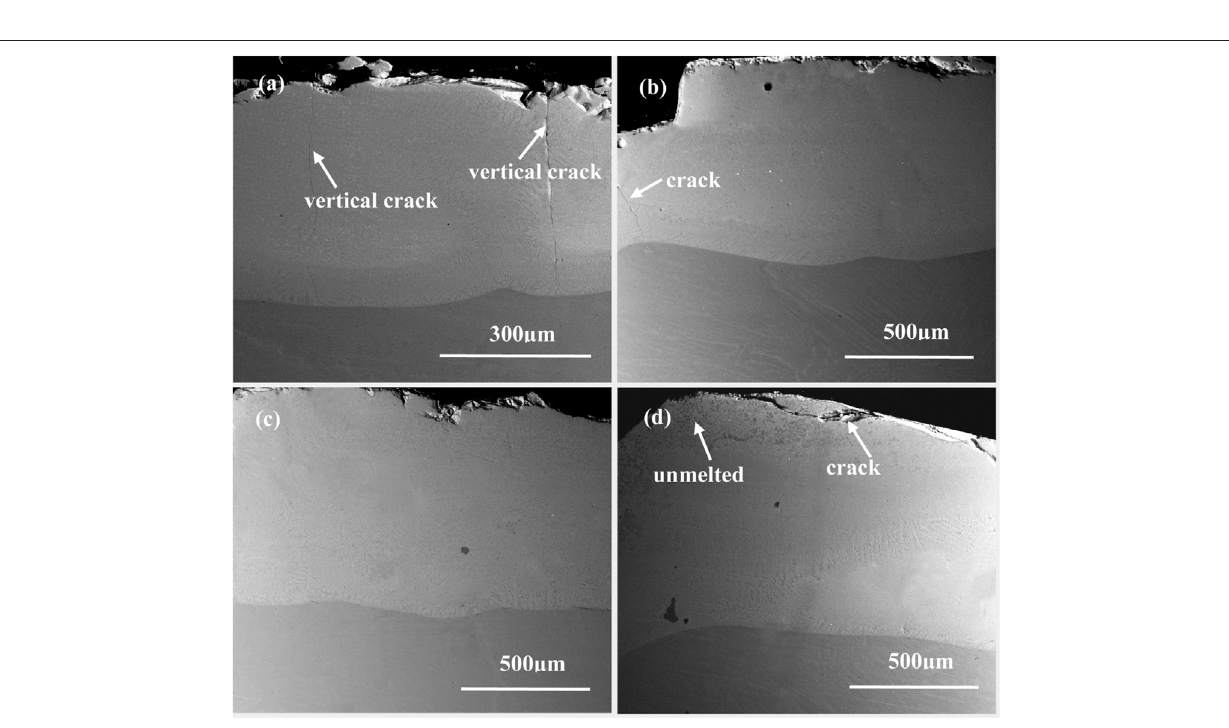
Frontiers in Materials |